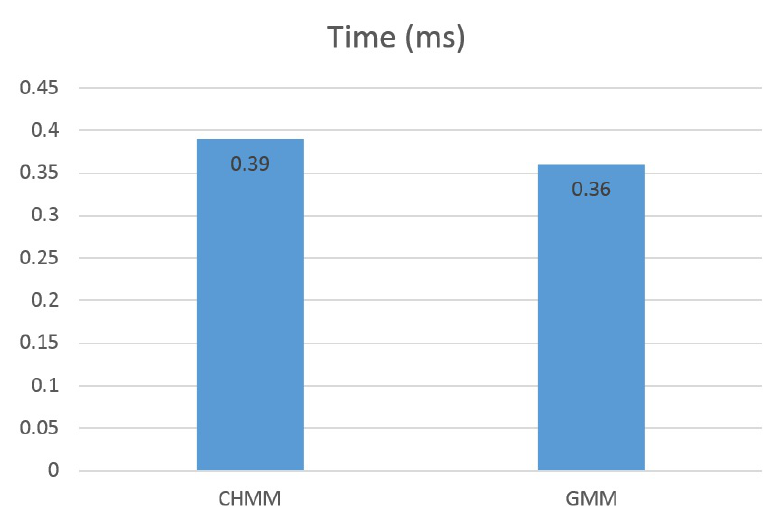
Figure 10. Average CPU processing time during the recognition of each evaluation movement using both continuous hidden Markov model (CHMM) and GMM methods.